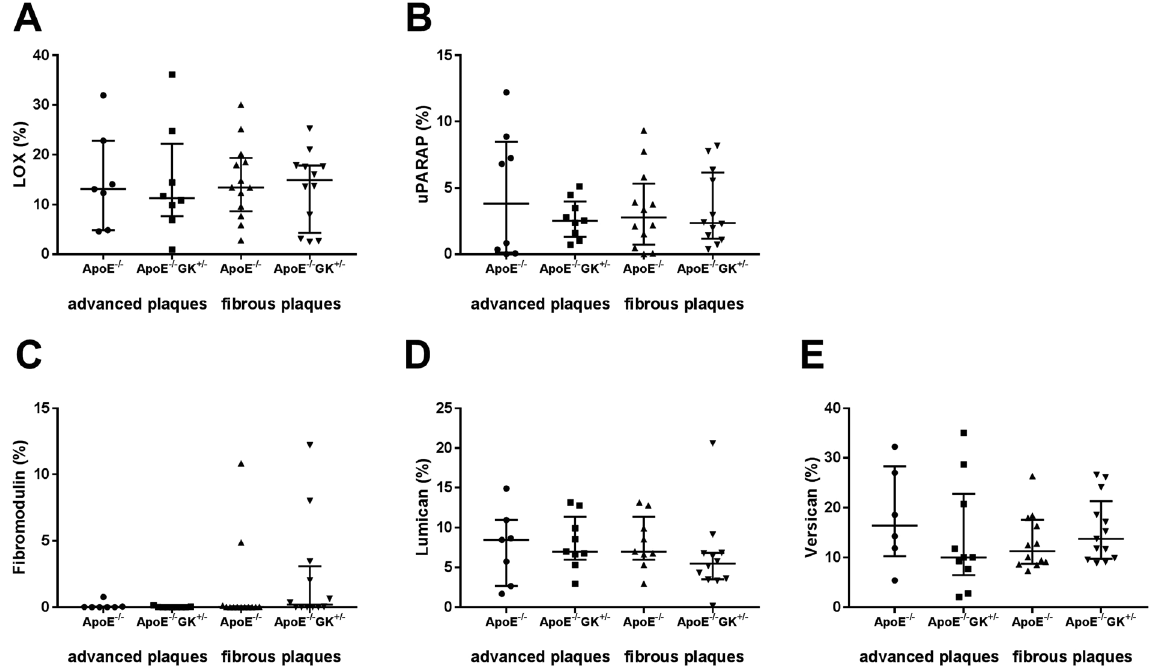
Figure 5. Analyses of the expression of proteins involved in extracellular matrix turnover in the induced carotid lesions. No difference could be observed in the levels of lysyl oxidase (LOX) ( A ), uPARAP ( B ), fibromodulin ( C ), lumican ( D ) or versican ( E ) between the ApoE − / − GK + / − and ApoE − / −